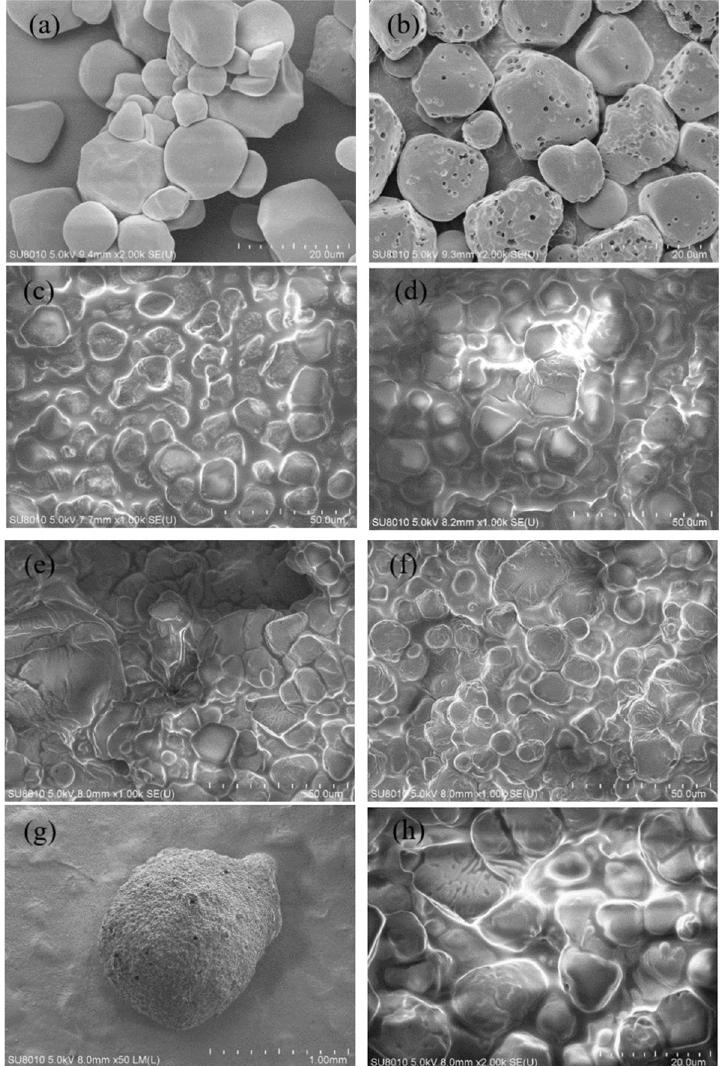
Figure 2. Scanning electron microscopy of starch and microcapsules: ( a ) natural starch; ( b ) modified starch; ( c ) group A microcapsules, magnification ratio: 1000 × ; ( d ) group B microcapsules, magnification ratio: 1000 × ; ( e ) group C microcapsules, magnification ratio: 1000 × ; ( f ) group D microcapsules, magnification ratio: 1000 × ; ( g ) group C microcapsules, magnification ratio: 50 × ; and ( h ) group C microcapsules, magnification ratio: 2000 × .